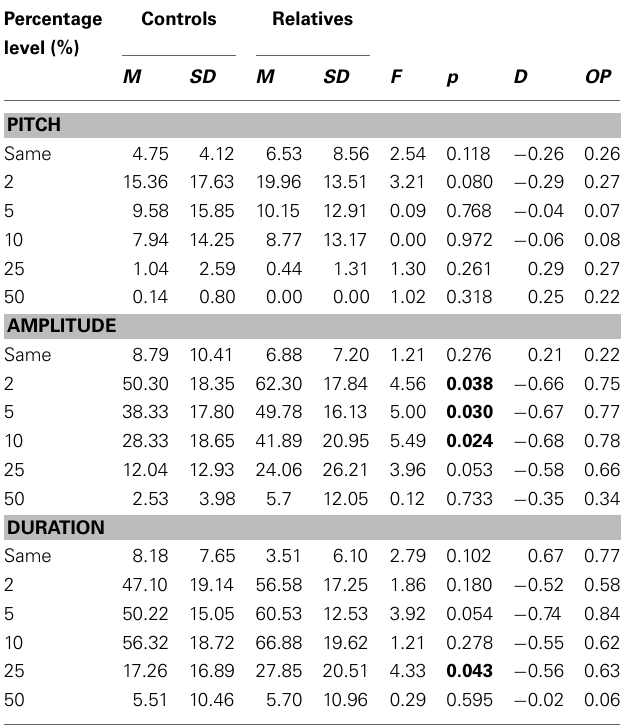
The analyses for this data were performed on log-transformed error-rates and controlled for age. The figures presented here are the untransformed error-rates to aid in interpretation. Bold numbers indicate that relatives made significantly more errors in identification of different tones than controls. OP, observed power.